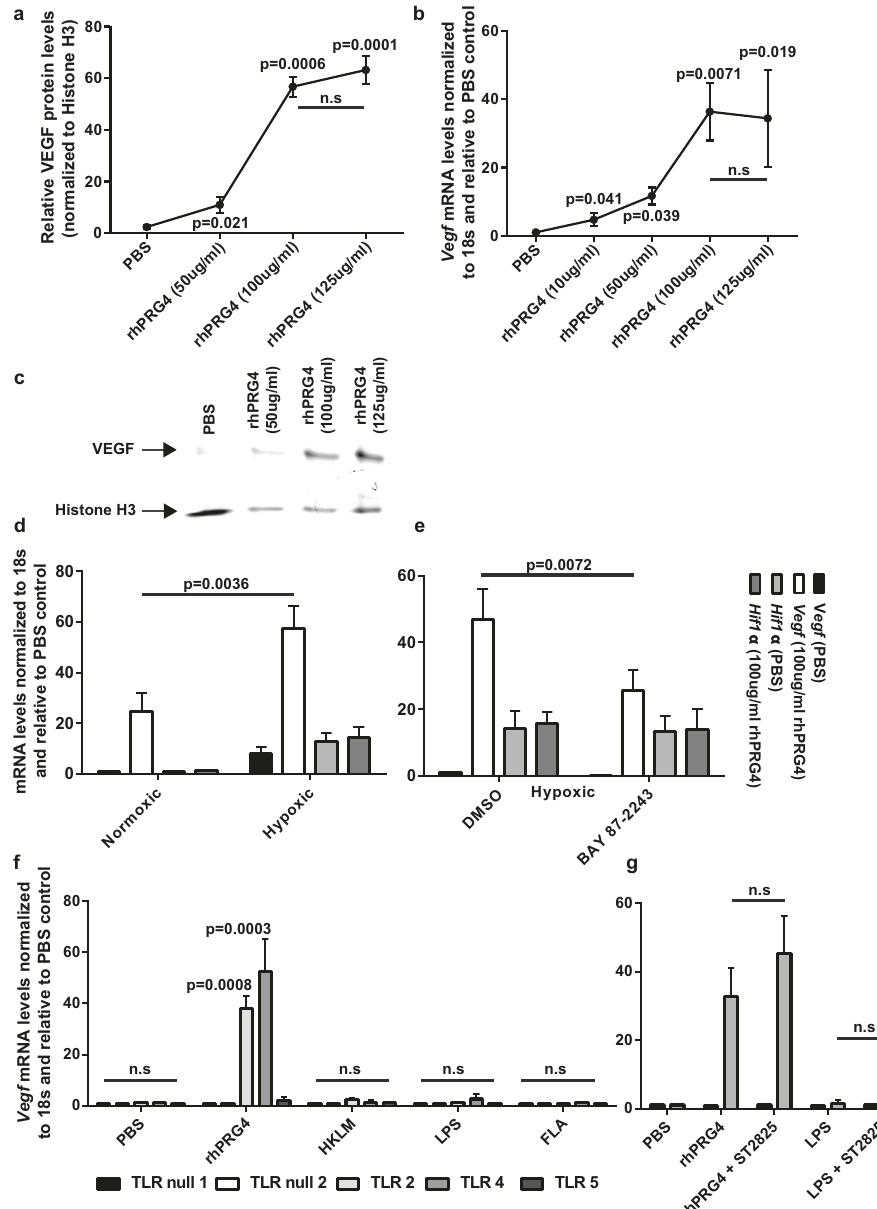
Fig. 3 rhPRG4 induces VEGF expression in vitro. In primary MEFs, rhPRG4 induced VEGF protein expression in a dose dependent manner with a plateau at 100 µg/ml a , b . This effect was con fi rmed at the mRNA level c . Vegf and Hif1 α mRNA expression was quanti fi ed under normoxic and hypoxic conditions in the presence or absence of rhPGR4 and/or Hif1 α inhibition (BAY 87-2243) to demonstrate that rhPRG4 induction of Vegf was independent of Hif1 α d , e . To determine if Vegf activation was downstream of Toll-like receptors (TLRs), HEK cells lacking all TLRs or expressing a single TLR (2, 4 or 5) were treated with rhPRG4 or their speci fi c agonist f . TLR4 expressing cells demonstrated the maximal Vegf activation (f) and this activation was independent of MYD88 activity since the MYD88 inhibitor (ST2825) had no effect on rhPRG4 Vegf activation g . All experiments were undertaken on at least 3 biological and 3 technical replicates unless otherwise stated. n.s. = not signi fi cant. Error bars equal mean ± SD ( a , c , d – 1 way ANNOVA, f , g – t-test). treatment (Fig. 7l). However, by day 10 post-injury the number of proportion of the Ki67 + population expressing MPC markers MPCs in carrier alone group (DMSO) reached the same level as (Sca1 + CD140a + ) was examined, a dramatic increase in the number of proliferating progenitors was observed at 1 day post- rhPRG4 treated injuries (Fig. 7l). To further investigate this injury and was maintained until day 5 post-injury (Supplementary observation, the number of proliferating cells and proliferating Fig. 14b, d). However, by 10 days post-injury, this trend was MPCs within the injury site were investigated by fl ow cytometry reversed in where the number of proliferating MPCs in C57BL/6 analysis (Supplementary Fig. 14). The number of Ki67 + cells increased with rhPRG4 treatment and this was maintained over mice treated with DMSO was signi fi cantly increased vs. mice the fi rst 10 days post-injury (Supplementary Fig. 14a, c). When the treated with rhPRG4 (Supplementary Fig. 14b, d).